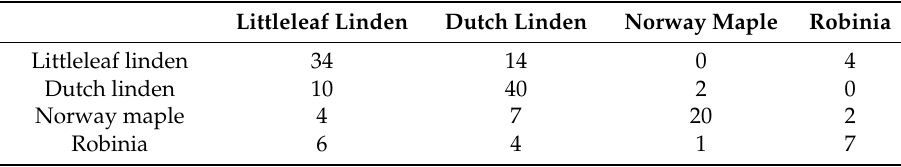
Table 9. Confusion-Matrix of tree species classification by MLS data.